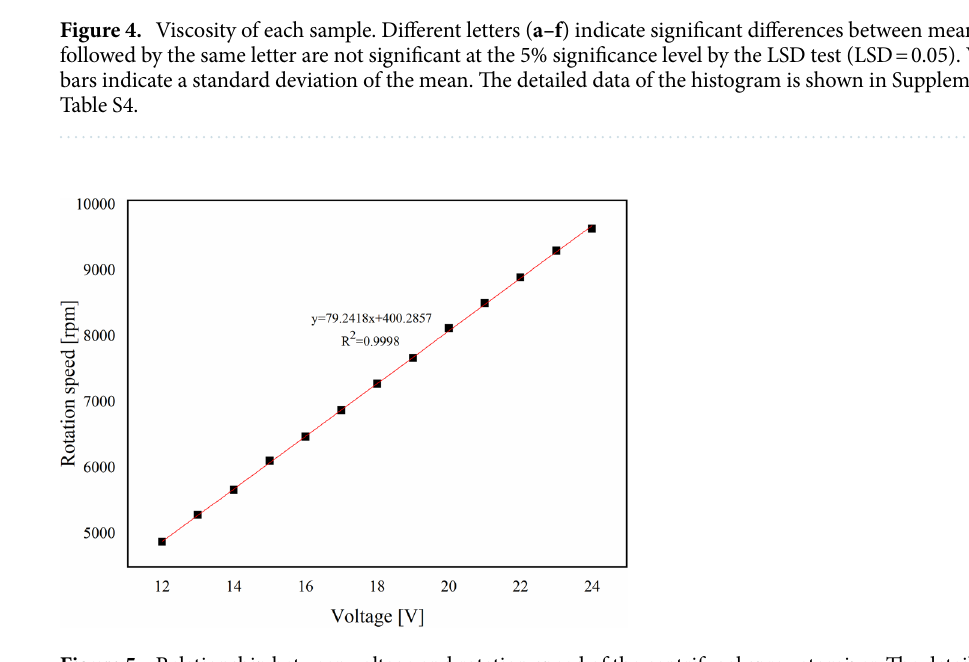
Figure 5. Relationship between voltage and rotation speed of the centrifugal spray atomizer. The detailed data of drawing the curve is shown in Supplementary Table